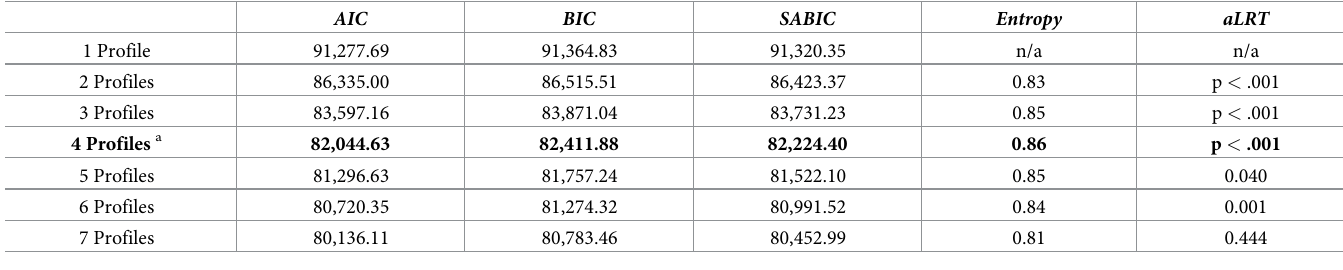
Table 3. Model selection indices for latent profiles